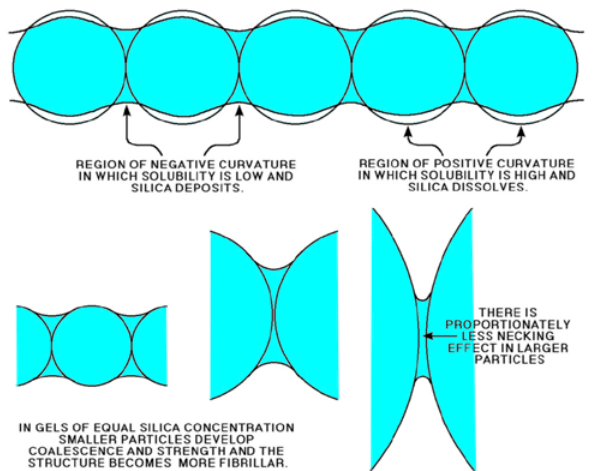
Figure 54. A chain of small particles is converted to a fibre or rod by the laws of solubility. Solubility at the negative radius of curva- ture of the neck between the spheres is less than elsewhere on the spheres so that, as the system tends to equilibrium, silica builds up in the region of the contacting spheres and "rounds off" protuber- ances. The effect is greater for smaller particle chains. [Adapted from Iler 2 , 1979, p. 230]